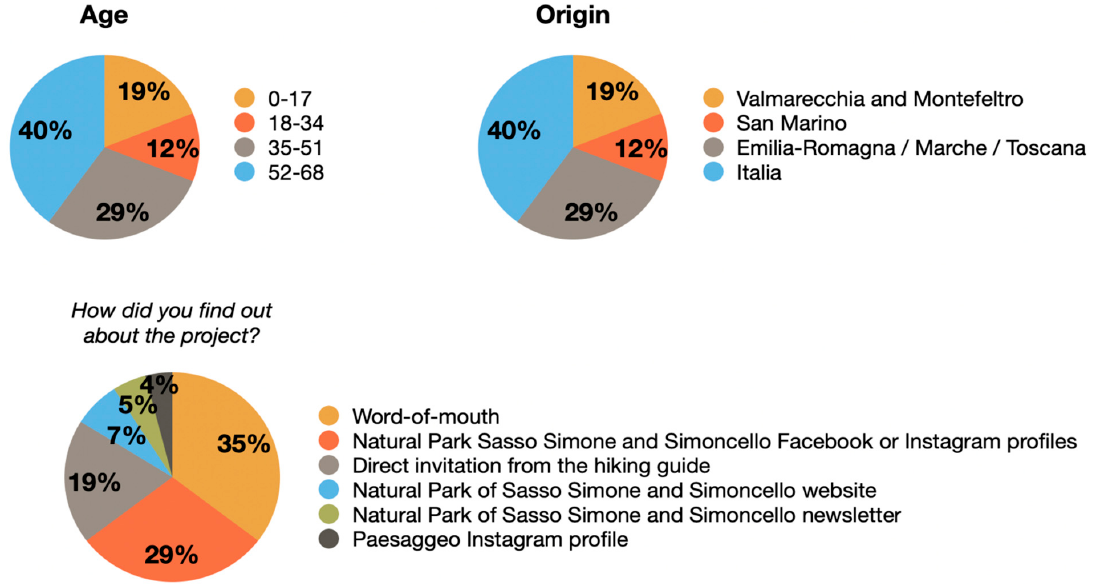
Figure 11. Age and origin of Paesaggeo ’s excursions participants, and how they learned about the project.